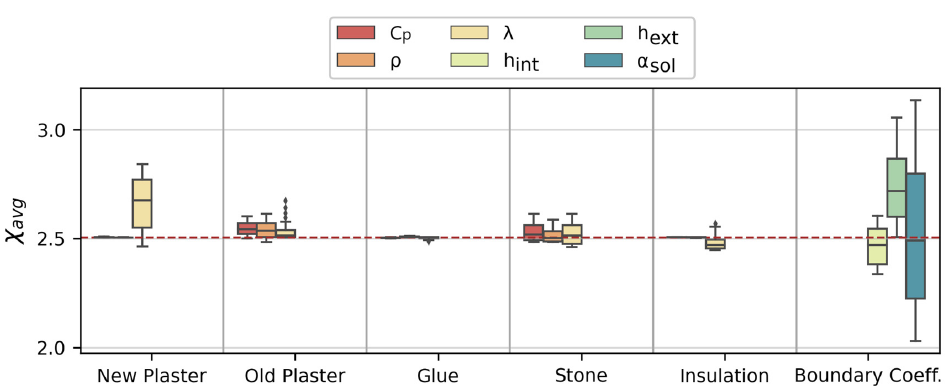
Figure 7. DSA for the average value of the three positions in the stratigraphy. There are parameter combinations that lower the overall 𝜒 (cid:3019)(cid:3014)(cid:3020)(cid:3006) value showing that there is a potential for improvement with respect to the first optimization process. Look- ing at the averaged value it is evident that the choice of 𝛼 (cid:3046)(cid:3042)(cid:3039) can consistently change the result. As it is evident from Figure 7 ( 𝜒 (cid:3028)(cid:3049)(cid:3034) ), the glue parameters do not affect the thermal simulation results as well as the density and specific heat of the new plaster and insula- tion. These parameters will not be varied during the second optimization phase. 3.2. Results of the second Optimization By using the software GenOpt with the genetic algorithm, a total of 3920 simulations were performed during the second optimization process. Some parameters were not taken into account during the optimization process because they were found to have a negligible influence on the numerical model using the sensitivity analysis. Material parameters and boundary condition coefficients were optimized in order to reduce the value of 𝜒 (cid:3019)(cid:3014)(cid:3020)(cid:3006) . Through optimization (second optimization process), it was possible to determine the ma- terial parameter and boundary coefficient values that reduced the differences between the output of the numerical model and the monitored data. Table 4 shows the comparison of material properties obtained from the first optimized simulation and the second optimi- zation process. In addition, the table reports the variation range and, when available, the values from the datasheet or laboratory measurements. For the new plaster and the insu- lation, the parameter 𝐶 (cid:3049)(cid:3042)(cid:3039) has not been varied since was found to have little influence from DSA. Table 5 shows the same values for the boundary coefficients.